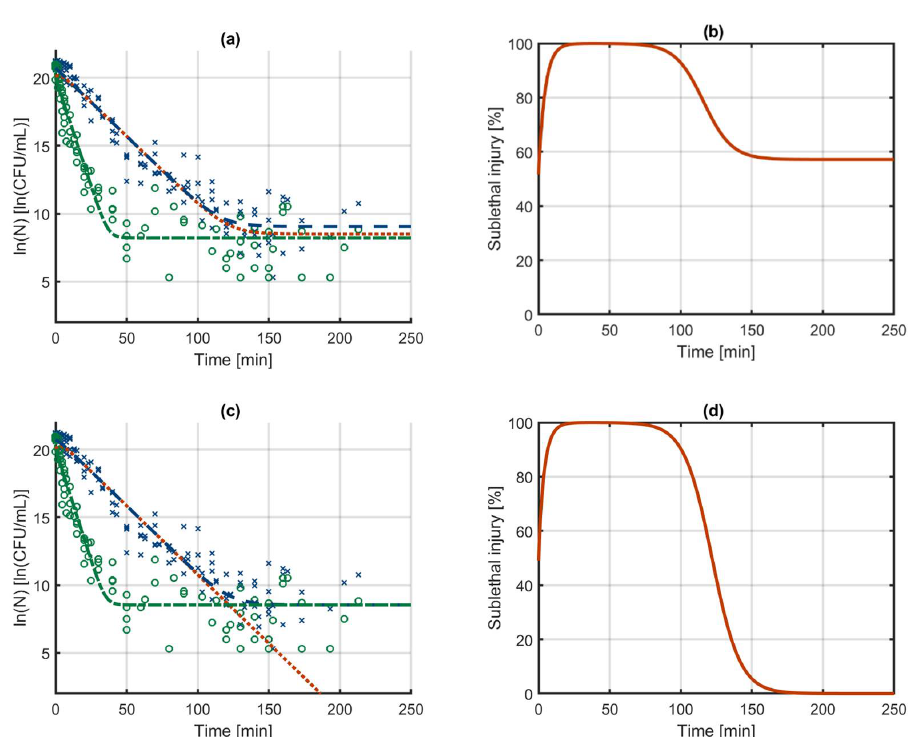
Figure 5. Log-linear inactivation with tailing of all culturable (—) and healthy culturable (- · -) cells as described by ( a ) the independent models and ( c ) the sublethal injury model that are constructed with the model of Geeraerd et al. [52]. Based on these modelling results, the evolution of the sublethally injured population (···) and the percentage sublethal injury (—), ( b , d ) are calculated. The data are based on counts of culturable ( x ) and healthy ( o ) cells on non-selective and selective media as published by Noriega et al. [12]. The data were obtained by heat-treating high-density colonies of Salmonella Typhimurium at 54 °C (Dataset 3).